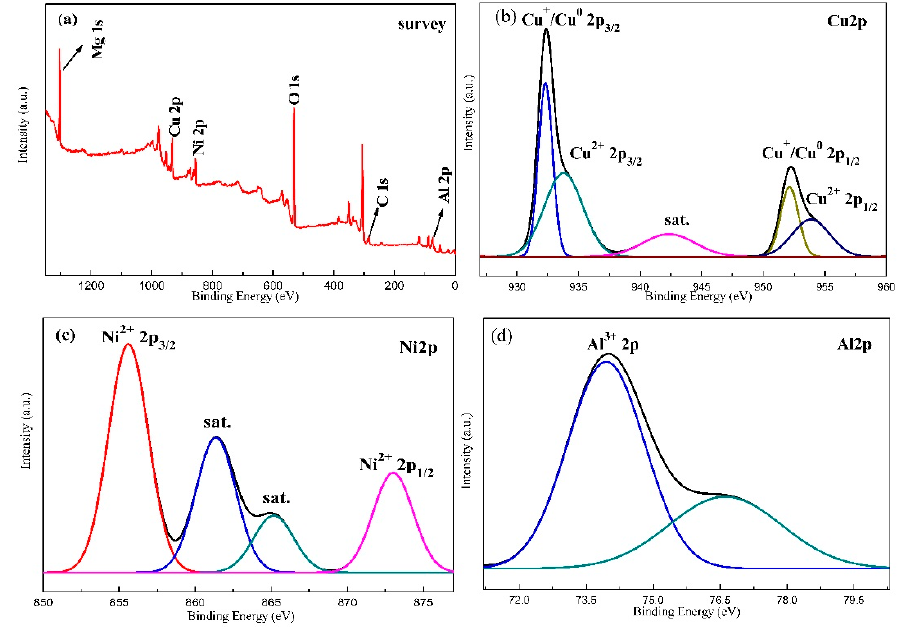
Figure 2. X-ray photoelectron spectroscopy (XPS) spectra of the reduced CNMA-4: ( a ) survey; ( b ) Cu2p; ( c ) Ni2p; and ( d ) Al2p.